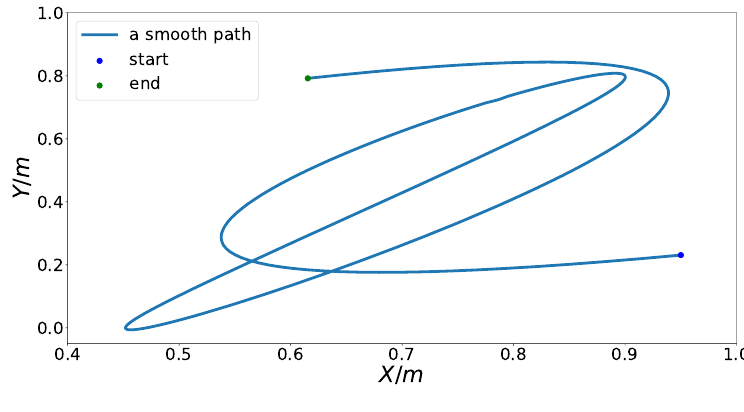
Figure 5. An example path from [3].